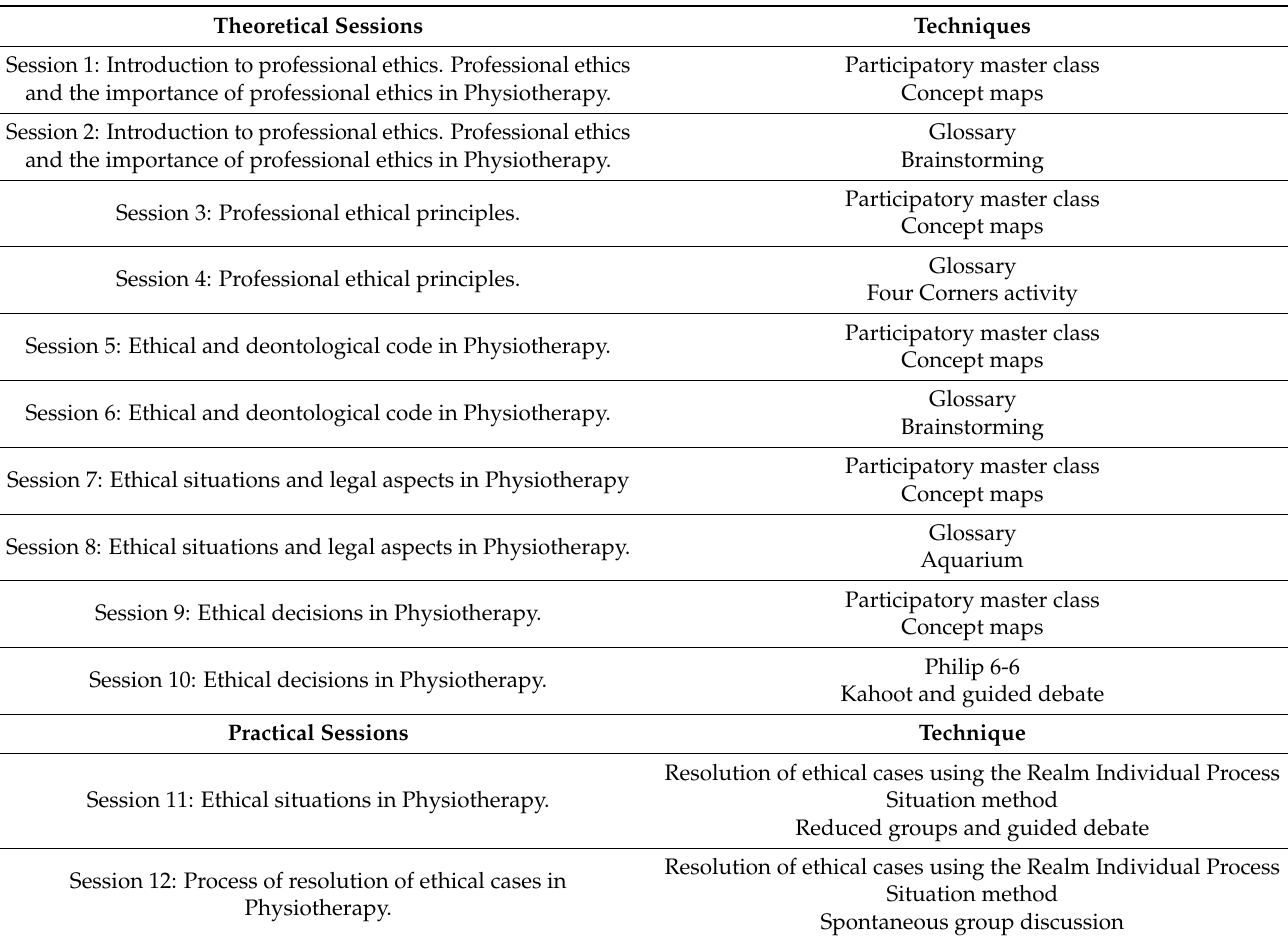
Table A1. Techniques used in each theoretical and practical session of the cooperative learning group.